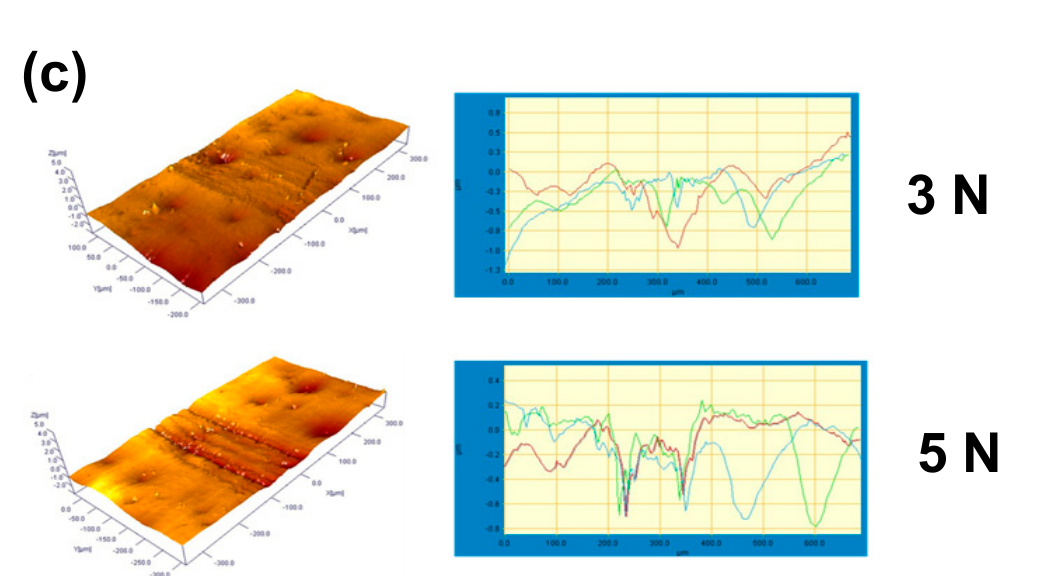
Figure 13. 3D wear track and corresponding 2D line profiles at 3 and 5 N loads: ( a ) bare β -21S (Ti-Mo) alloy substrate, ( b ) Mo-DLC coating with 30 min deposition, and ( c ) Mo-DLC coating with 60 min deposition. Table 3. Estimated wear losses during tribometric measurements for two different loads.